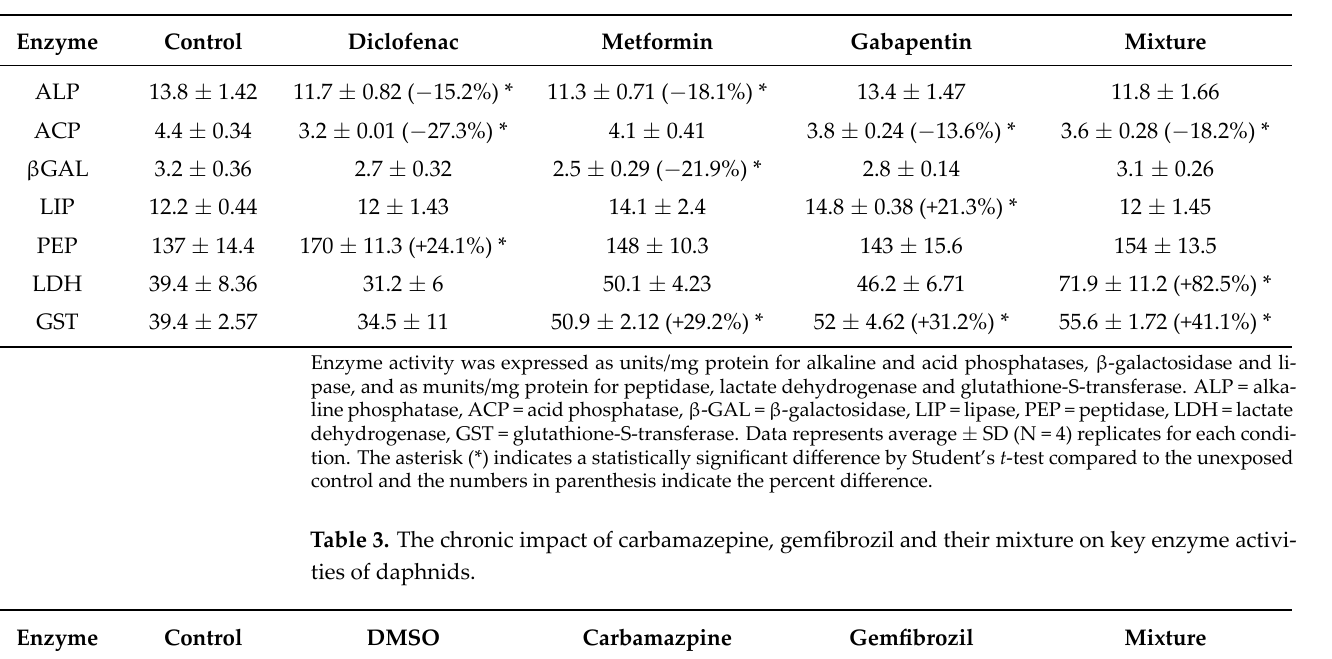
Table 2. The chronic impact of diclofenac, metformin, gabapentin and their mixture on key enzyme activities of daphnids.